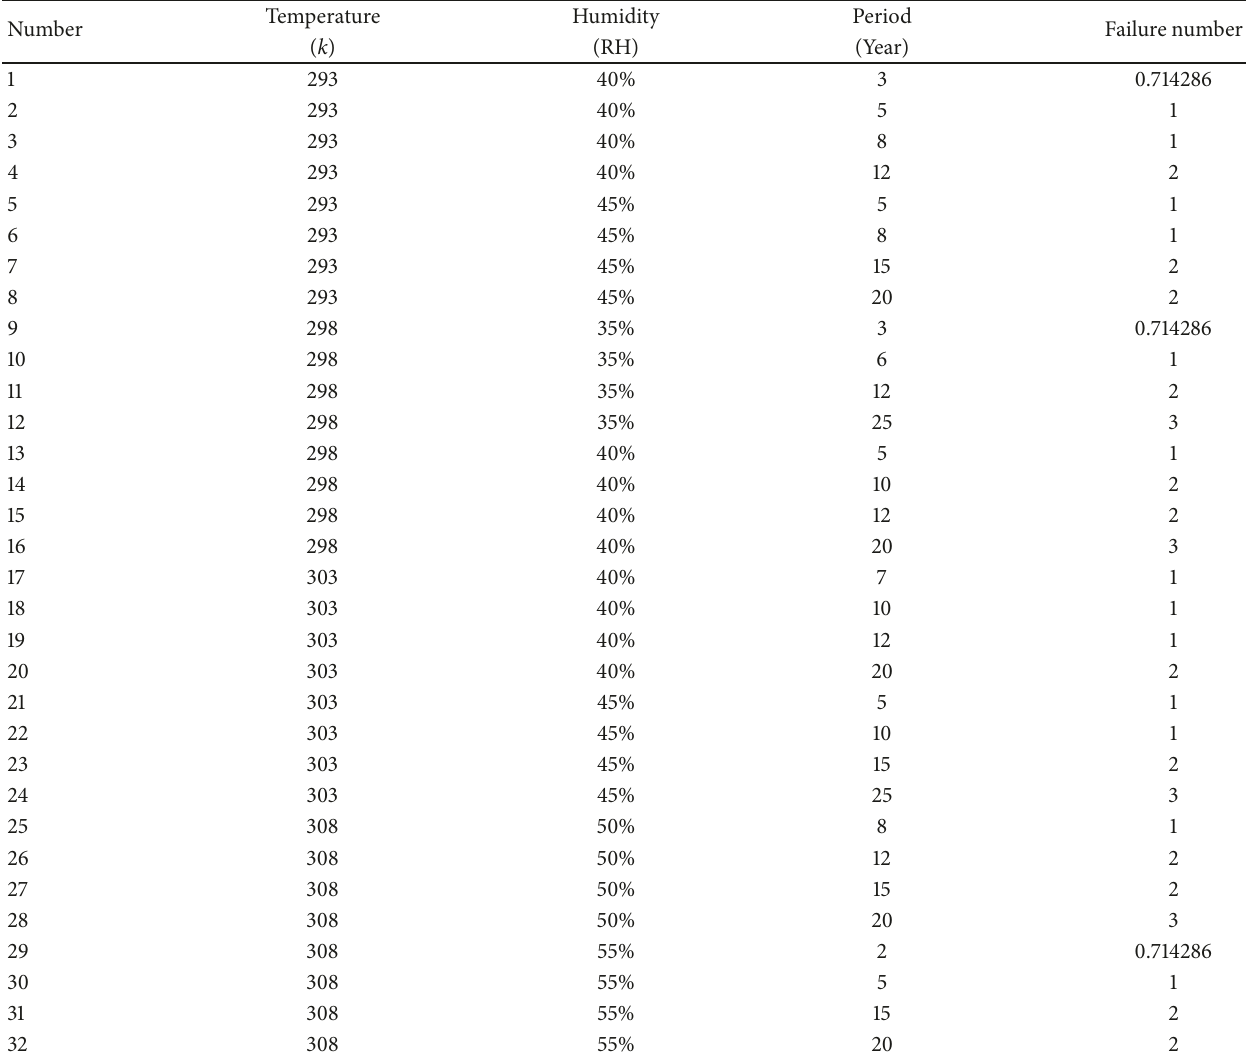
Table 2: Data after zero failure and inverted hanging treatment.